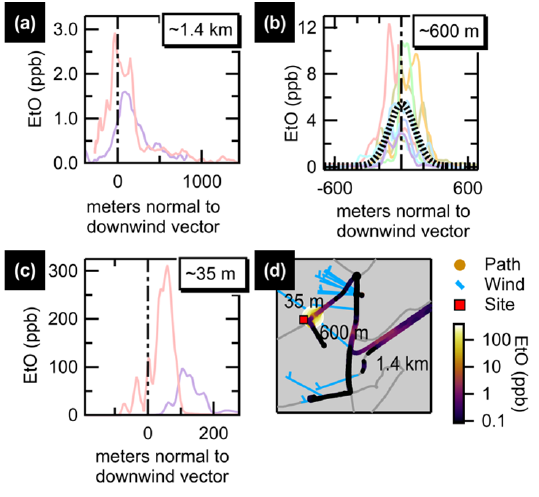
Figure 5. Summary of transects downwind of Facility A. Transects are plotted normal to the wind vector for paths driven along three roads approximately 1.4km (a) , 600m (b) , and 35m (c) downwind of Facility A. The average of 600m transects (dotted black line) is shown for panel (b) . A map (d) shows the facility location (red square) with the three main transect roads labeled by distance down- wind. The driven path is colored and sized by EtO concentration. Wind barbs (blue) are tethered to the truck path, with the feather end of the staff pointing into the